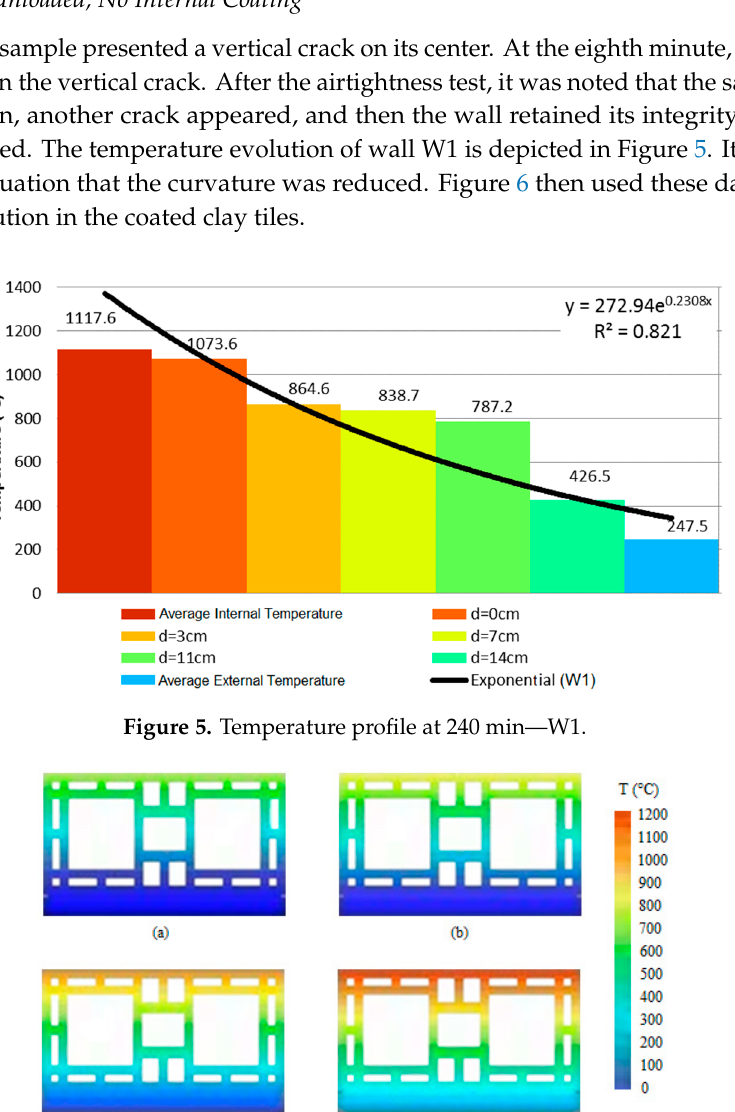
Figure 4. Attaching the samples to the test furnace.